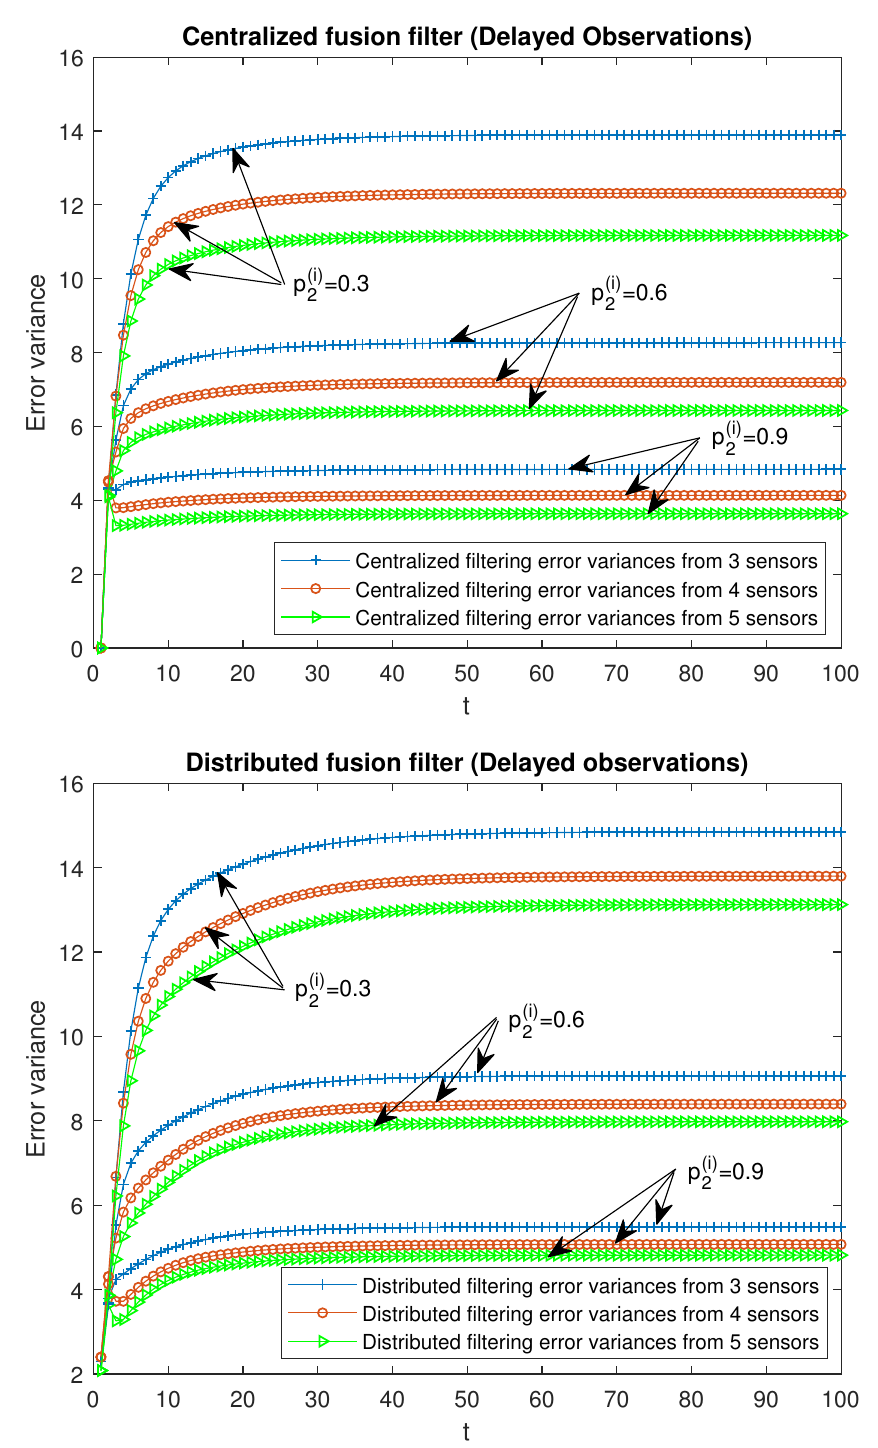
Figure 9. T 1 -proper fusion filtering error variances from delayed observations with 3, 4 and 5